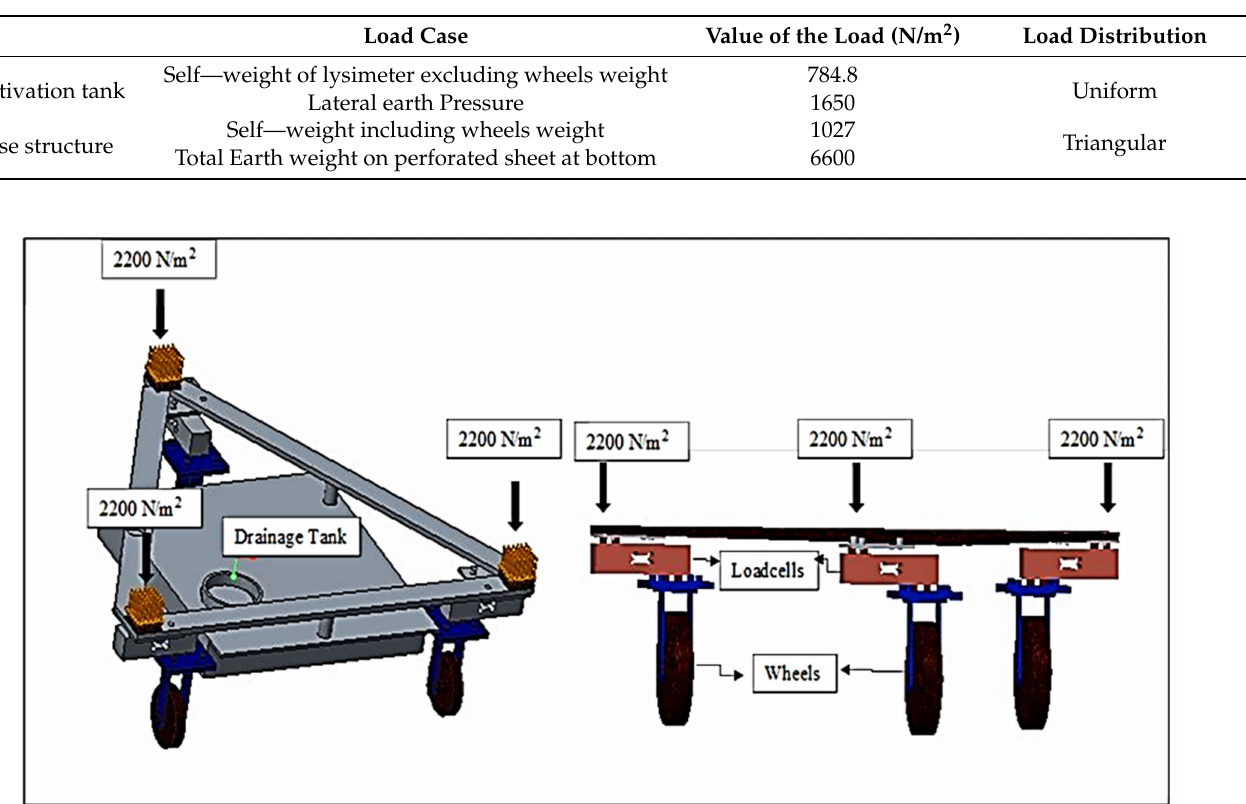
Table 2. Different load cases were considered for the cultivation tank and the base structure.